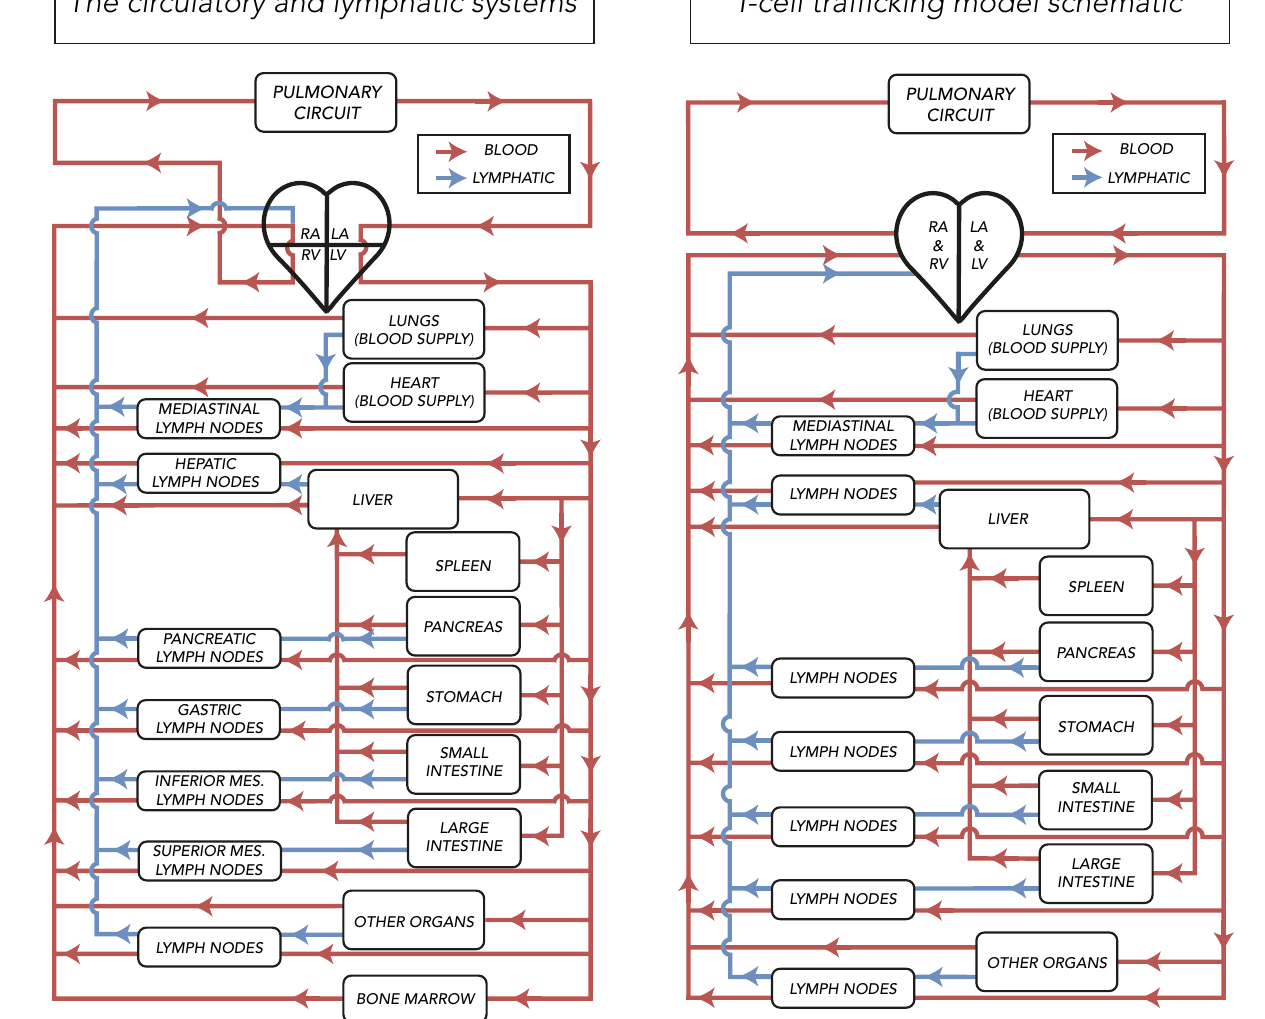
Figure 2. Model schematic of the ODE system (right) compared to the simplified schematic of the blood and lymph circulation (left). As a PBPK framework, the T cell trafficking model comprises of anatomical compartments corresponding directly and faithfully to the organs and tissues of the body, connected by the cardiovascular and lymphatic system. Such a description of anatomy is used to predict a systemic and tissue exposure to the circulating T cells. Cells flow from the left atrium and left ventricle of the heart to each organ (red lines), via lymphatics (blue lines) into organ-draining lymph nodes and return back to the right atrium and right ventricle of the heart. Each box represents a vasculature and interstitium compartment. Chambers of the heart: RA —right atrium, RV —right ventricle, LA —left atrium, LV —left ventricle. Other organs compartments include: adrenals, bladder, brain, adipose tissue, gonads, kidneys, skeletal muscles, skeleton, skin, thyroid. Note that the skeleton compartment in the model includes the bone marrow and bones and is parameterised accordingly (see Table